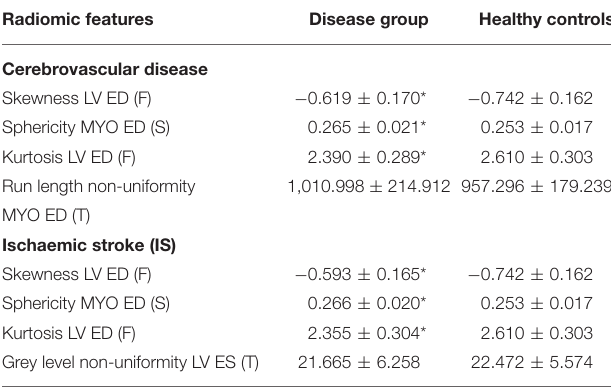
TABLE 4 | Selected top-ranked most discriminative shape, first-order and texture features for cerebrovascular disease and ischaemic stroke (IS) compared to healthy controls.